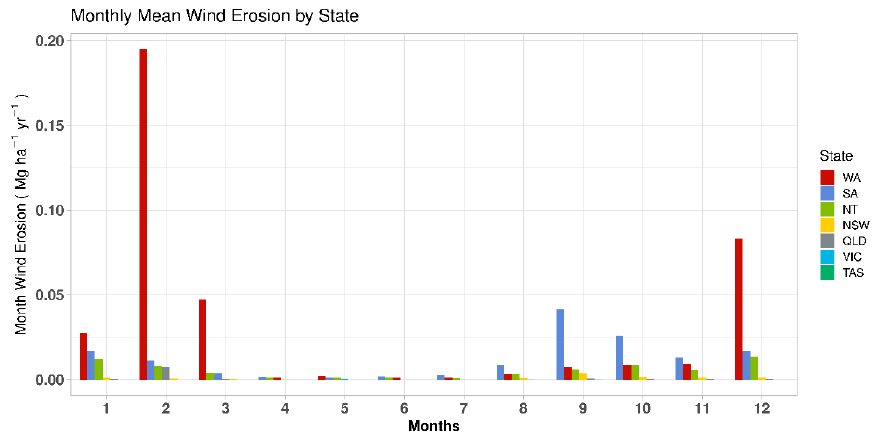
Figure 7. Bar chart of monthly wind erosion by state based on the RWEQ in 2001–2020. Maps of the RUSLE and RWEQ estimated erosion and uncertainty are shown in Figure 8. The uncertainty calculation method used is the range of the 95% confidence intervals over the predicted annual average soil loss. We note that the largest water erosion rates existed around the Kimberley Plateau in northern Australia, Canning Basin in Western Australia, Simpson Desert in central Australia, the coastal wet tropics in Western Australia, and on the south-east slopes in New South Wales and Victoria. Compared to the agricultural areas, the rangeland areas of inland Australia experienced relatively larger water erosion loss, and these larger uncertainties might be due to the rainfall erosivity estimates for dryland areas. On the other hand, wind erosion rates were relatively higher in the rangeland areas where the vegetation cover is sparse, while the uncertainty of wind erosion was notably different between inland regions and coastal regions, as larger uncertainty values are found in the latter.